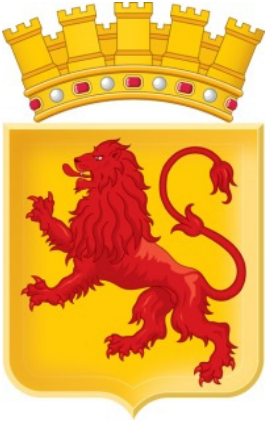
Figure 6. T he 2014 proposal.